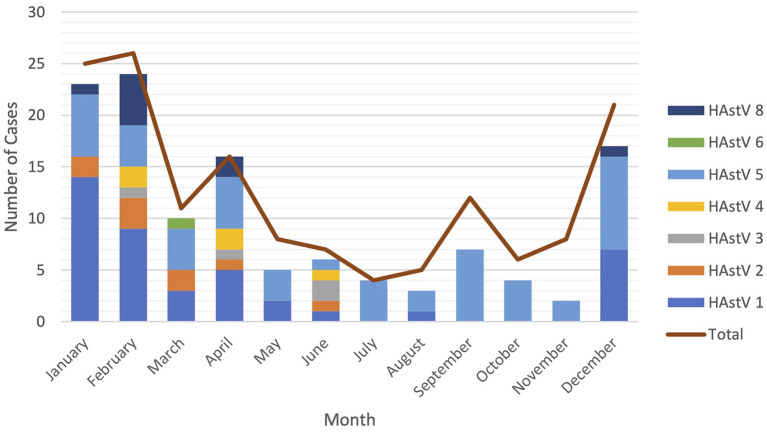
Seasonal distribution of astrovirus genotypes. Different color bars represents different genotypes of astrovirus. Red line is total cases of astrovirus detected monthly.